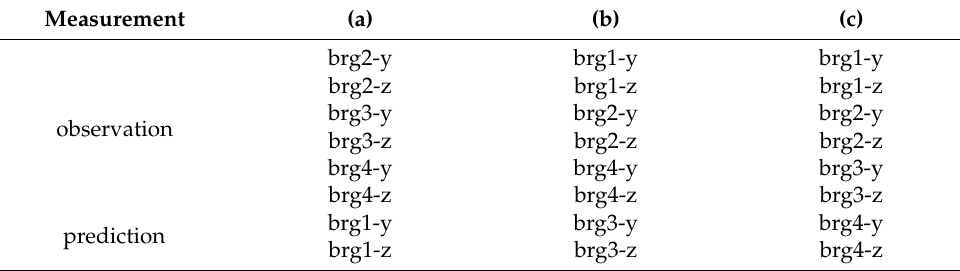
( b ) Figure 18. Kalman filter for prediction and validation, brg3- as prediction, calculated response at bearing 1 ( a ) bearing 1-y, ( b ) bearing 1-z. for estimation of the acceleration for test-a. ( a ) brg1-y, ( b ) brg 1-z. 4.2.4. Deflection along the Rotor This section uses the eight measurement points of the bearing locations (nodes 2, 6, 7, and 8 of the FEM model) as an observation, and the rotor movement in all nodes are plotted in Figure 19. It can be seen from Figure 19a that the highest movement appears near discs 3 and 4 (nodes 9–12). There is a clear movement near disc 1. Discs 1, 3, and 4 are quite heavy (17.22 kg, 16.11 kg, and 3.88 kg, respectively). This caused the amplitude of the predicted acceleration at these locations to become high. In the middle of the rotor and near the bearing location, the amplitude is relatively small, as the movement is re- stricted. The estimated pattern by the Kalman filter agrees reasonably well with the first forward whirling mode shape of the rotor at 700 rpm (Figure 19b), which has a significant contri- bution to the rotor deflection shape. It should be noted that, according to the Campbell diagram, the frequency of the first forward at 700 rpm is 46 Hz, while the 1X excitation appears at 7 Hz. The first forward mode is not the only mode contributing to the deflection